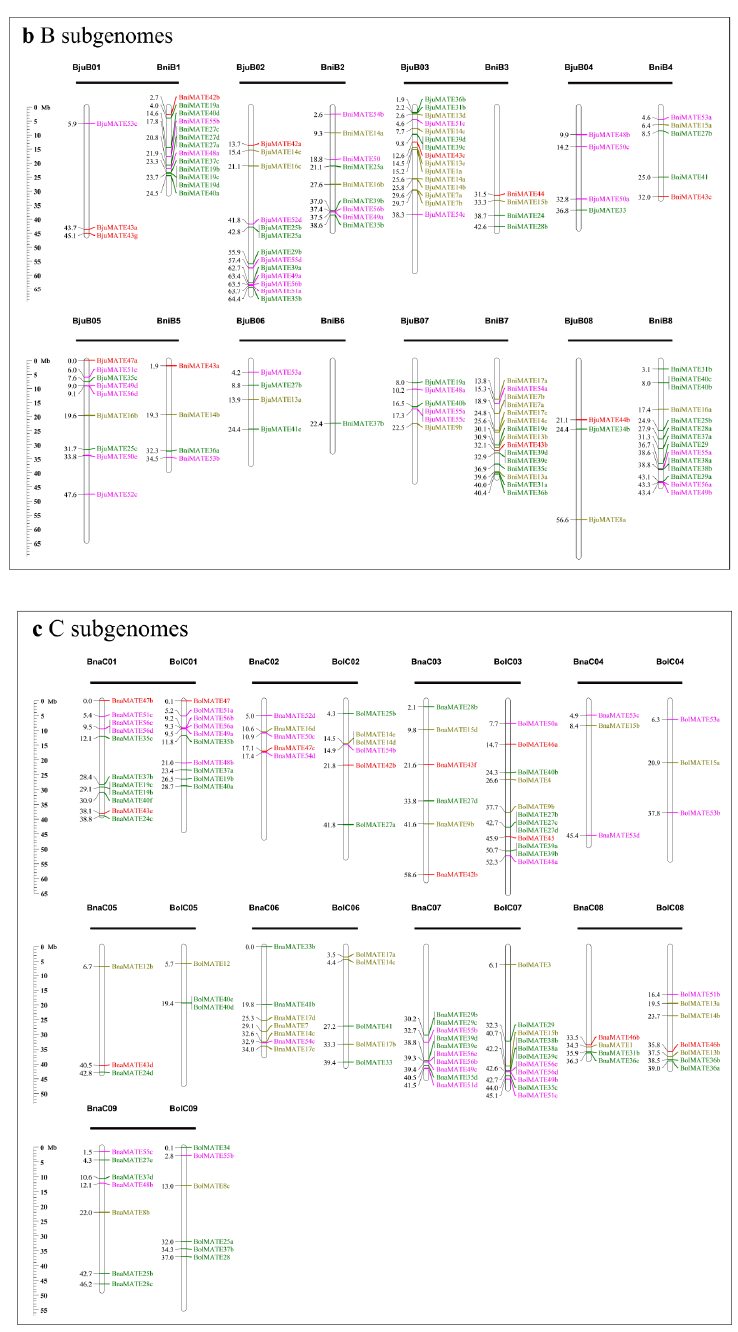
Figure 2. Chromosomal distribution and analysis of duplication events in MATE family genes among Brassicaceae species. ( a ) Chromosomal distribution and analysis of duplication events in MATE family genes among A subgenome. ( b ) Chromosomal distribution and analysis of duplication events in MATE family genes among B subgenome. ( c ) Chromosomal distribution and analysis of duplication events in MATE family genes among C subgenome. Genes from the same subgroups are indicated by the same color, which is consistent with that for the corresponding family in the phylogenetic tree (Figure 1); genes located on the sca ff old are not shown. The labels on the corresponding chromosomes indicate the source organism and the subgenome. The scales indicate the sizes of the various Brassica genomes (Mb). Bra, B. rapa ; Bol, B. oleracea ; Bni, B. nigra ; Bna, B. napus ; Bju, B. juncea